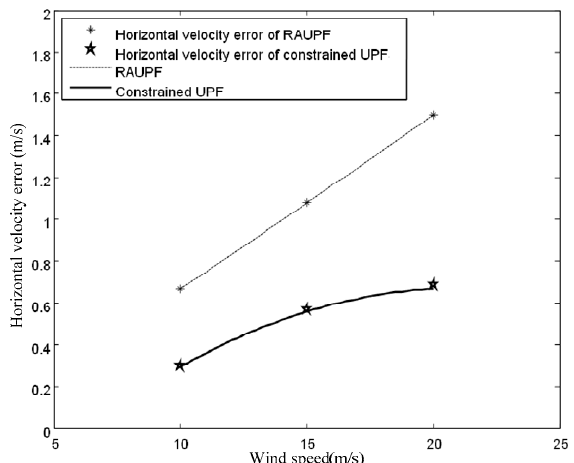
Figure 9. Horizontal velocity errors for both RAUPF and constrained UPF.